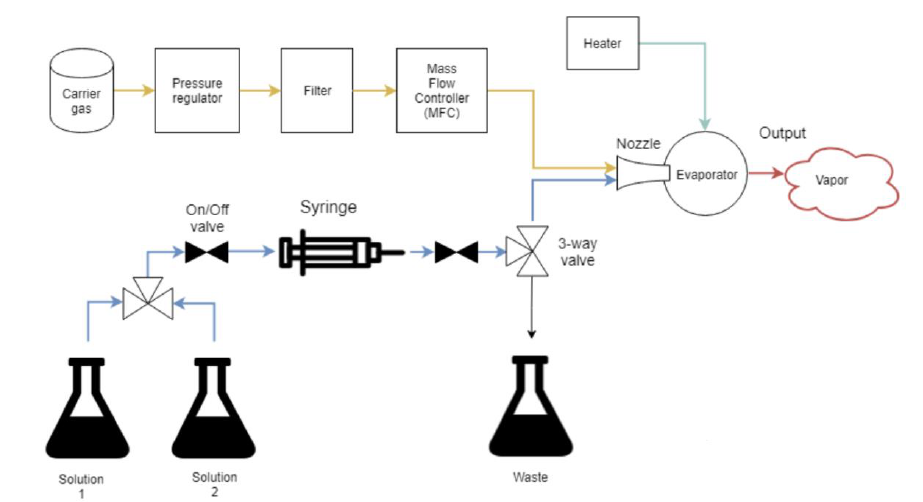
Figure 1. The flowchart of the liquid evaporative generator developed by Optoseven Ltd. and VTT Ltd. The output HgCl 2 gas concentration is calculated by applying Equations (1) and (2).